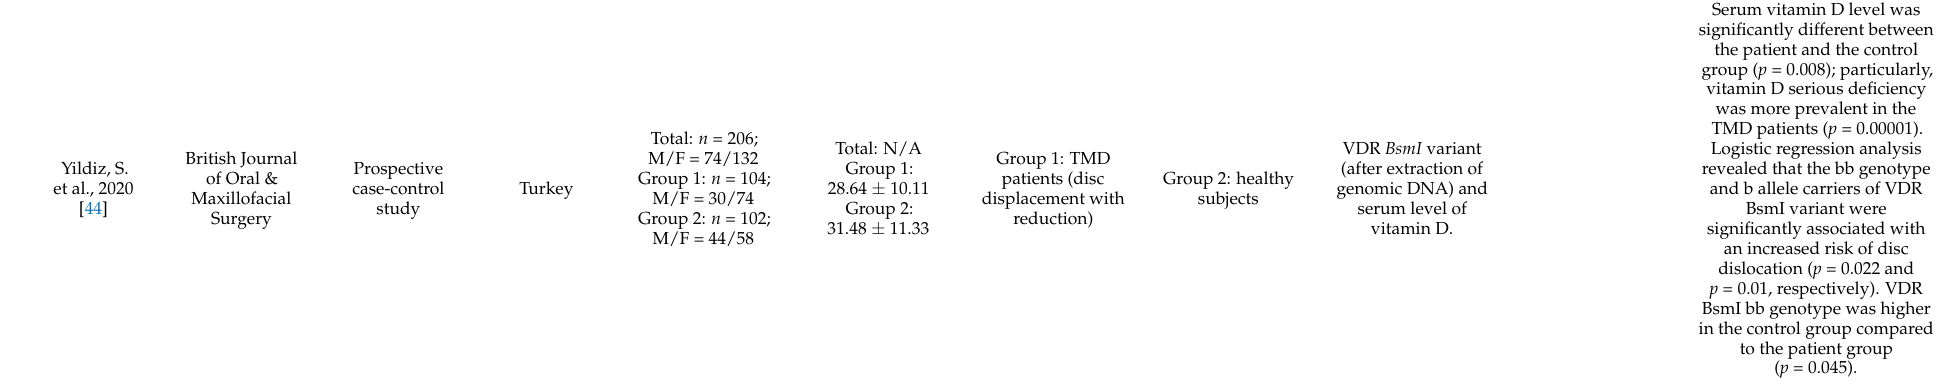
Group 2: healthy